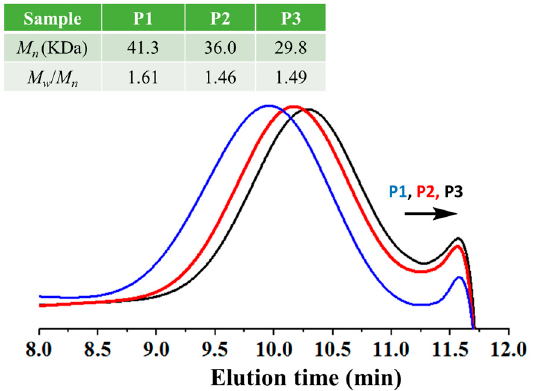
Figure 1. Gel permeation chromatography ( GPC) traces of methyl vinyl silicone oils P1-P3 .